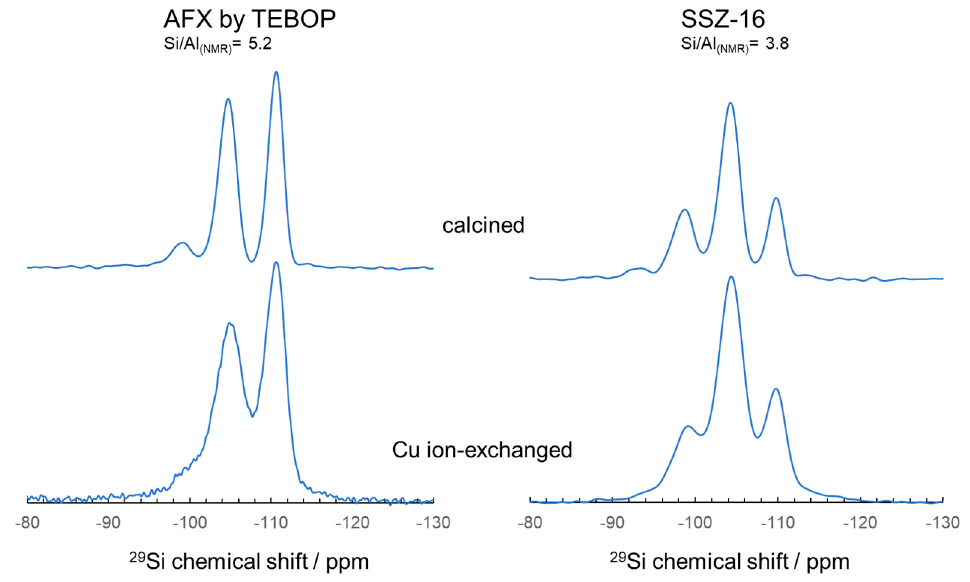
Figure 7. 29 Si MASNMR spectra for AFX ( left ) and SSZ-16 ( right ) as-calcined ( top ) or Cu ion-exchanged ( bottom ) samples.